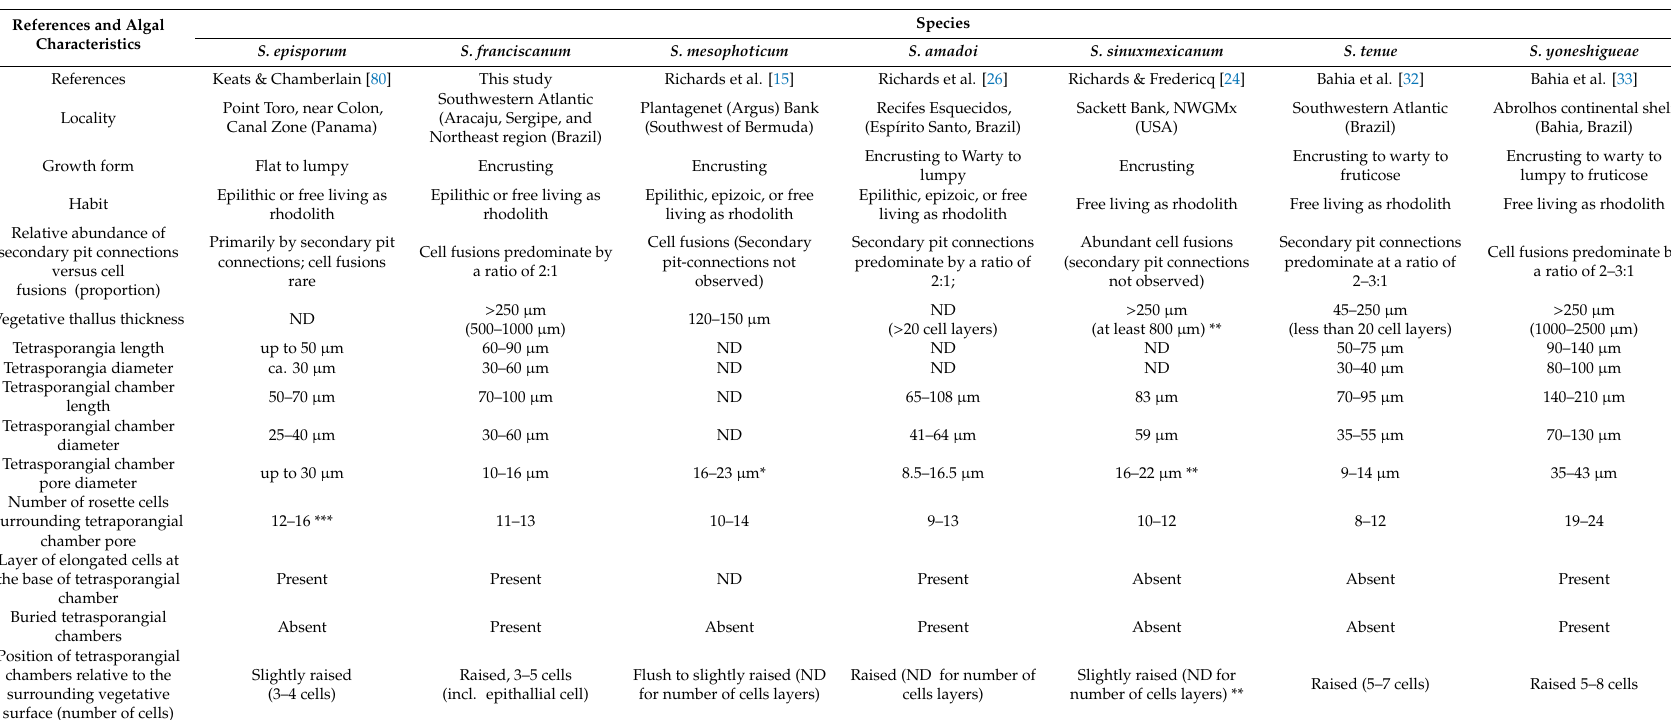
Table 2. Characteristics found to be informative in separating species of Sporolithon occurring in the Atlantic Ocean for which recent detailed descriptions are available. Descriptions are included only for species for where type / ’topotype’ specimens and for where representative specimens were confirmed by DNA sequence data. ND = No data provided. * Measure taken from Richards et al. [15]. ** Based on images from field-collected specimens provided by Richards et al. [24]. *** Measure taken from Keats et al.